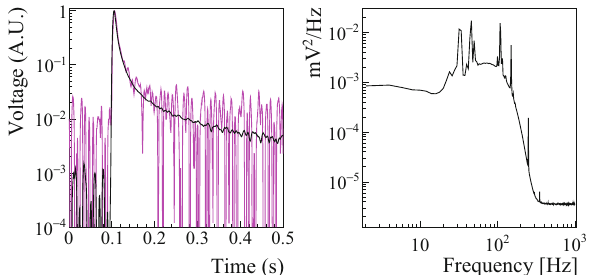
Fig. 7 Left:atypicaltemplateofaLDresponse(blackline)overlapped to a single light pulse acquired by the same detector (magenta line). The signal template was evaluated averaging hundreds of light pulses emitted by the bottom ZnSe crystal in order to suppress the random noise fluctuation. Right: a typical average noise power spectrum of a LD.Themicrophonicnoisepicksandtheroll-offduetotheanti-aliasing active Bessel filter are clearly